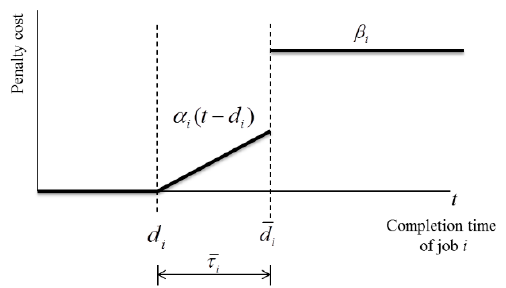
Figure 1. The penalty cost function.